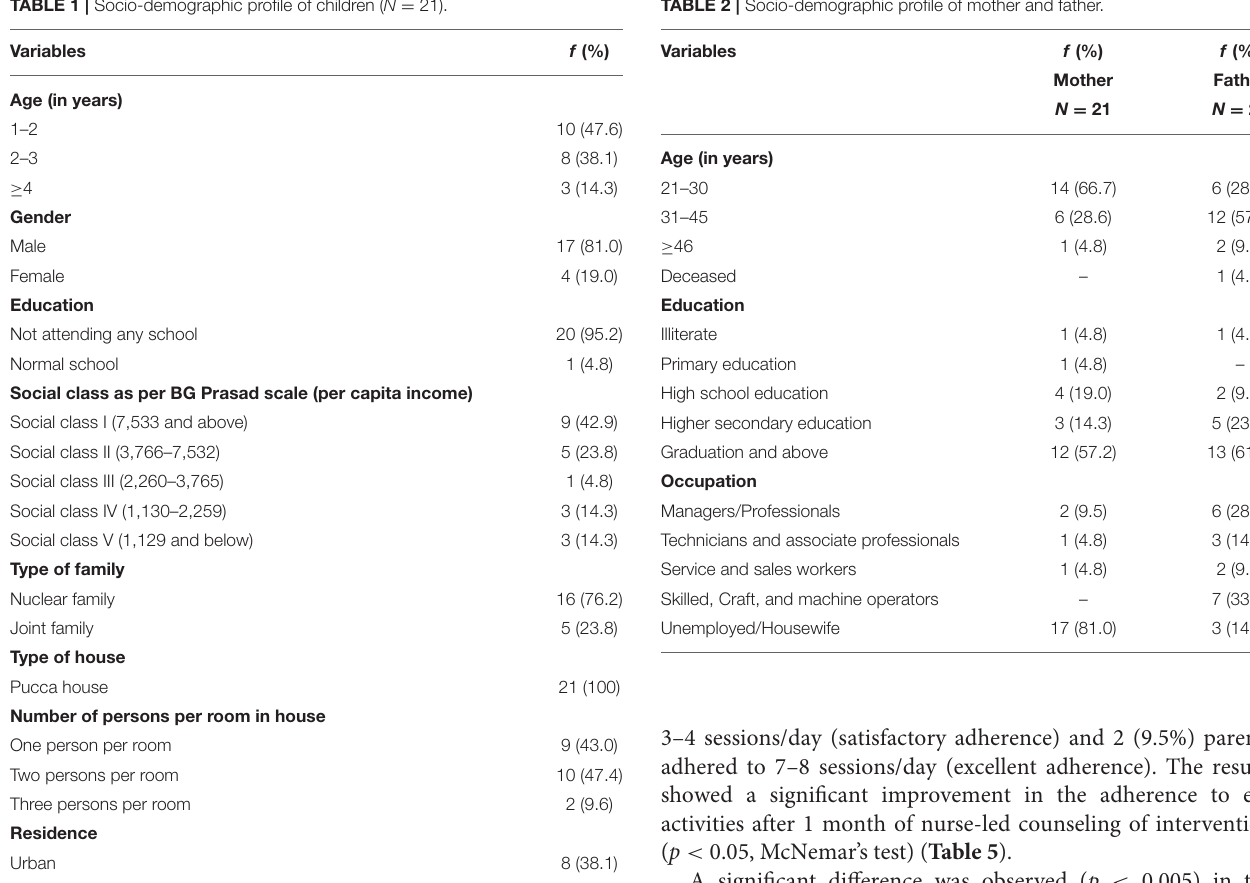
TABLE 1 | Socio-demographic profile of children ( N = 21). TABLE 2 | Socio-demographic profile of mother and